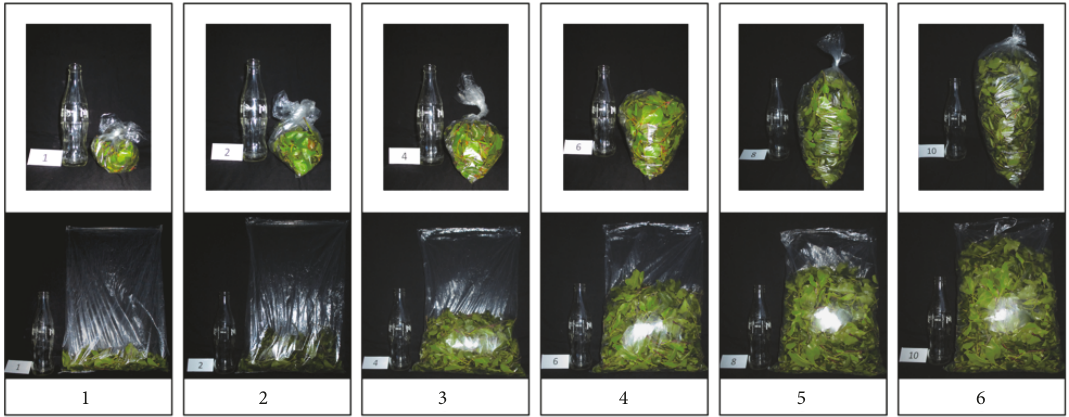
Figure 1: The visual analogue scale used to quantify the use of khat in grams. (1) 100 grams; (2) 200 grams; (3) 400 grams; (4) 600 grams; (5) 800 grams; (6) 1000